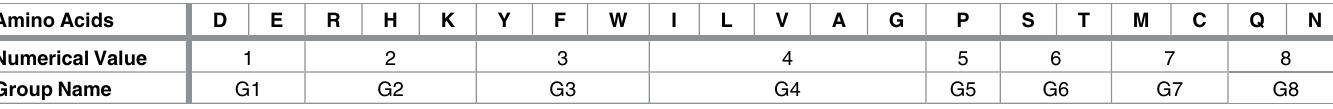
Table 2. Mapping Twenty standard amino acids to eight chemical groups of amino acids. Amino